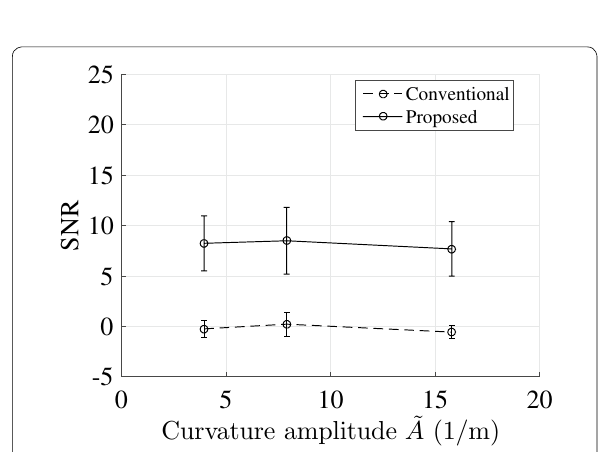
Fig. 9 Graph showing the relationship between the curvature amplitude ˜ A and the SNR